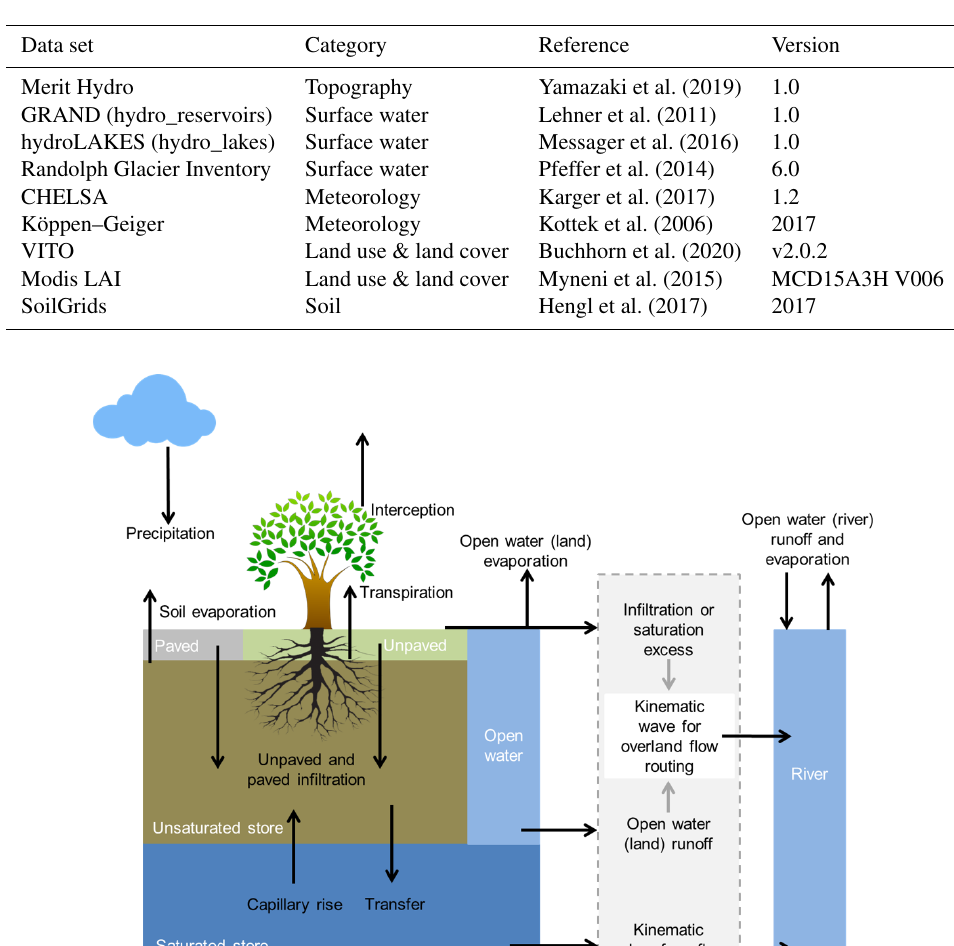
Figure 2. Overview of the different processes and fluxes in the wflow_sbm model (Schellekens et al., 2020).